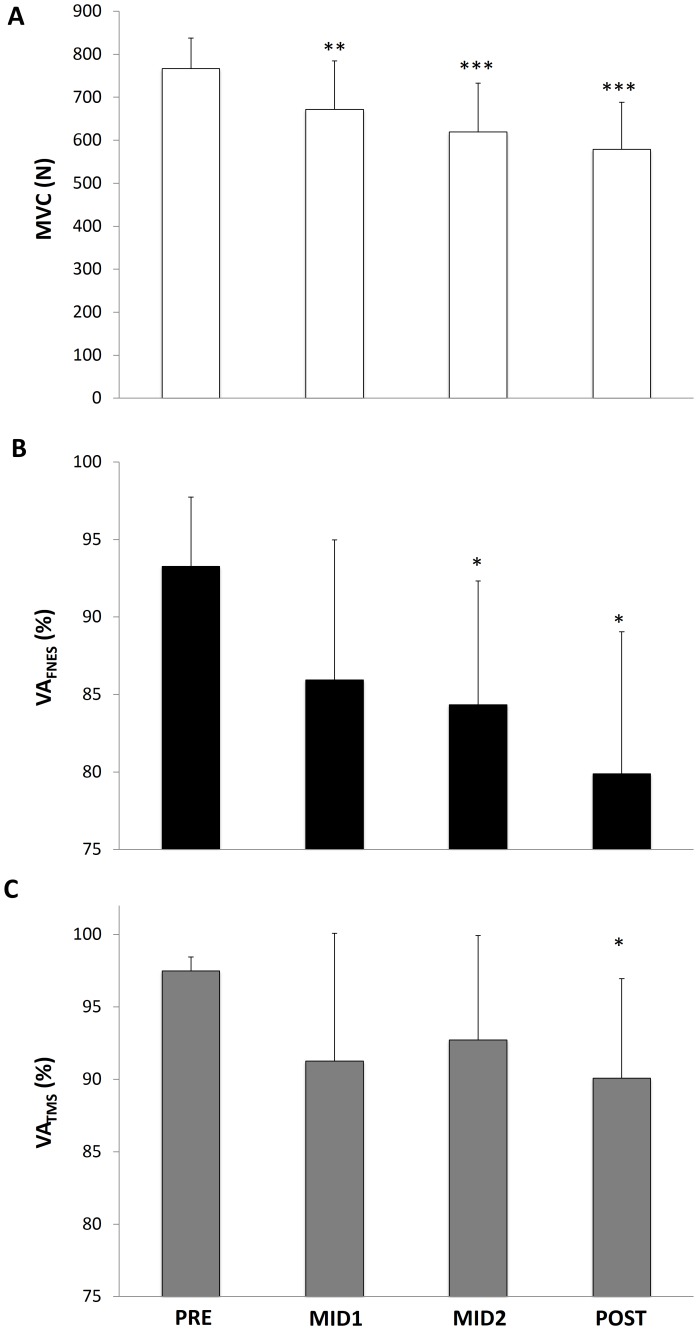
Maximal voluntary contraction (MVC) force (panel A), maximal voluntary activation assessed by interpolated twitch technique (VAFNES, panel B) and maximal voluntary activation assessed by transcranial magnetic stimulation (VATMS, panel C) of the knee extensor muscles, before (PRE), after 80 min (MID1) and 160 min (MID2) of cycling and after the 4-h cycling exercise (POST).Significantly different from PRE: *P<0.05, **P<0.01, ***P<0.001.